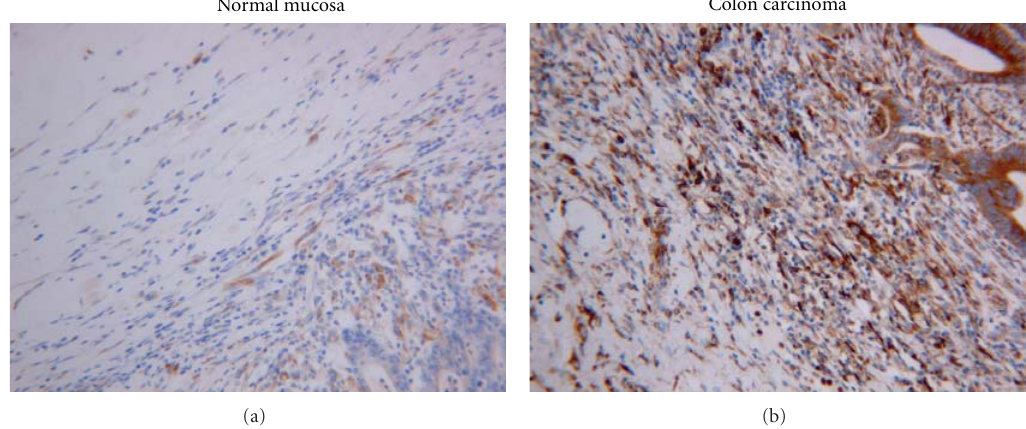
Figure 6: The di ff erence in Cx43 expression in the stromal component in normal mucosa and colonic adenocarcinoma (original magnification × 200). Cx43 reactivity was stronger in the stromal components adjacent to cancerous epithelium than benign epithelium: normal (Cx43 score 19 ± 1), cancer (Cx43 score 45 ±